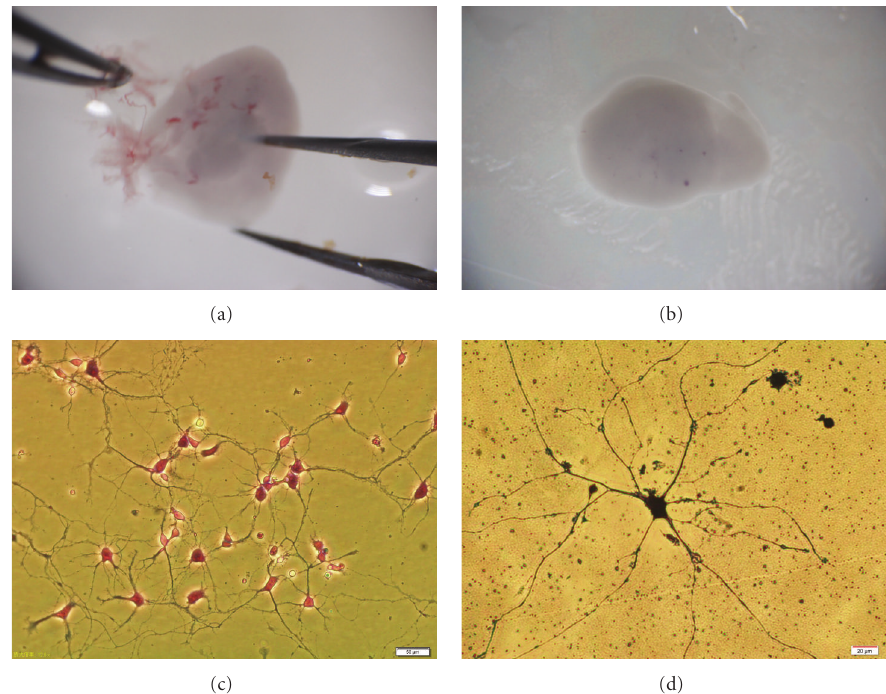
Figure 4: (a) Dissection of pia mater and blood vessels, (b) dissection degree, (c) 5 DIV (HE staining, bar = 50um), and (d) 14 DIV (bar =